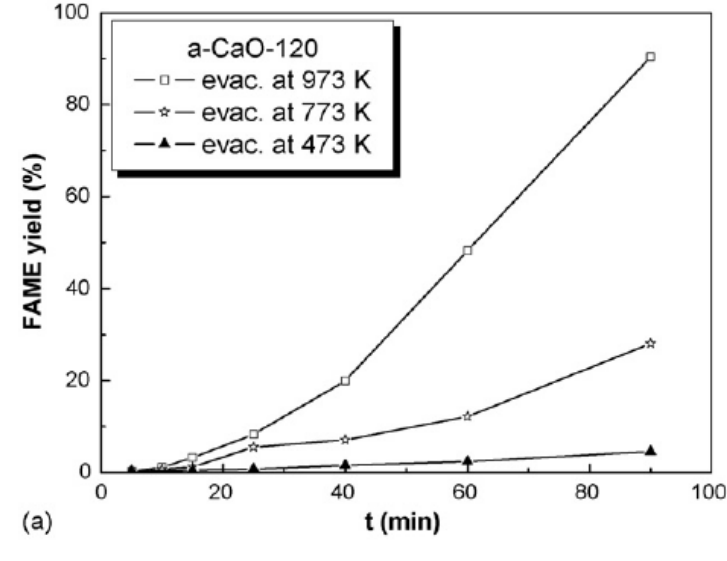
ester (FAME) yields (Notes: a-CaO-120 means that the fresh CaO was exposed to room air for 120 days; evac. at 473 K, activated at 473 K). The reaction conditions: sunflower oil; catalyst amount to oil, 1 wt.%; molar ratio of methanol to oil, 13:1, temperature, 333 K; reaction time 100 min at 1000 rpm. Reprinted with permission from [56].